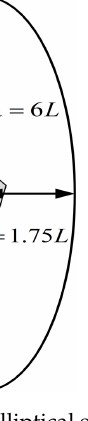
Figure 3. Elliptical ship domain.